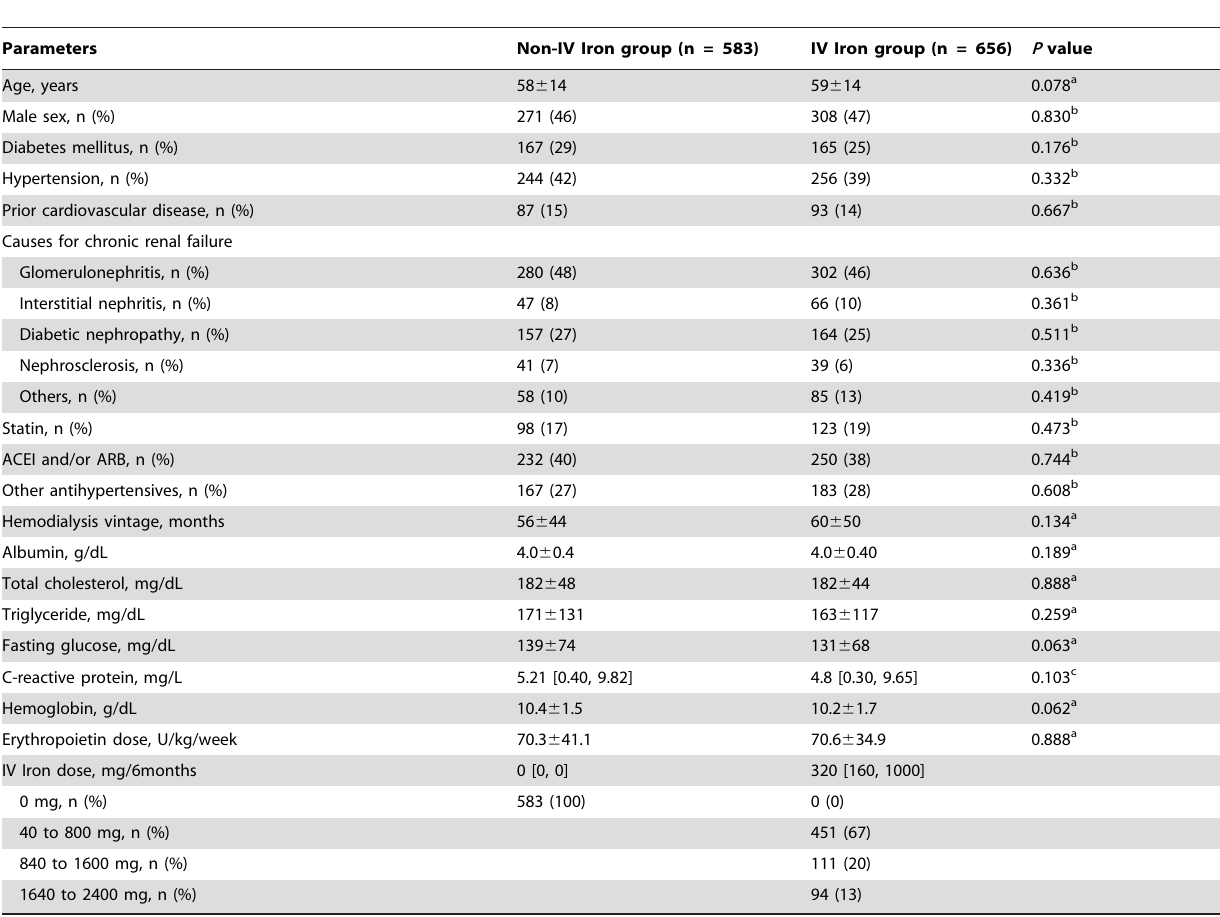
Table 1. Baseline characteristics of hemodialysis patients after receiving 6-month of IV administration of ferric chloride hexahydrate or